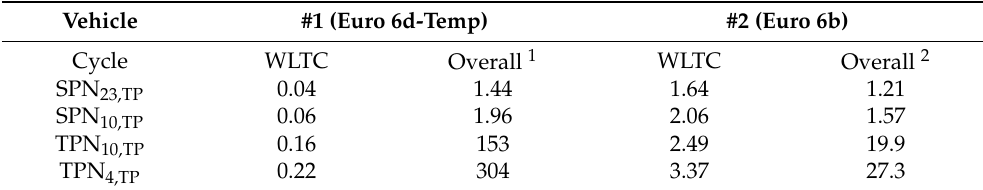
Table 2. Emissions ( × 10 11 #/km) of the two vehicles following the type approval cycle and including emissions during regeneration. Only measurements from the tailpipe were considered.